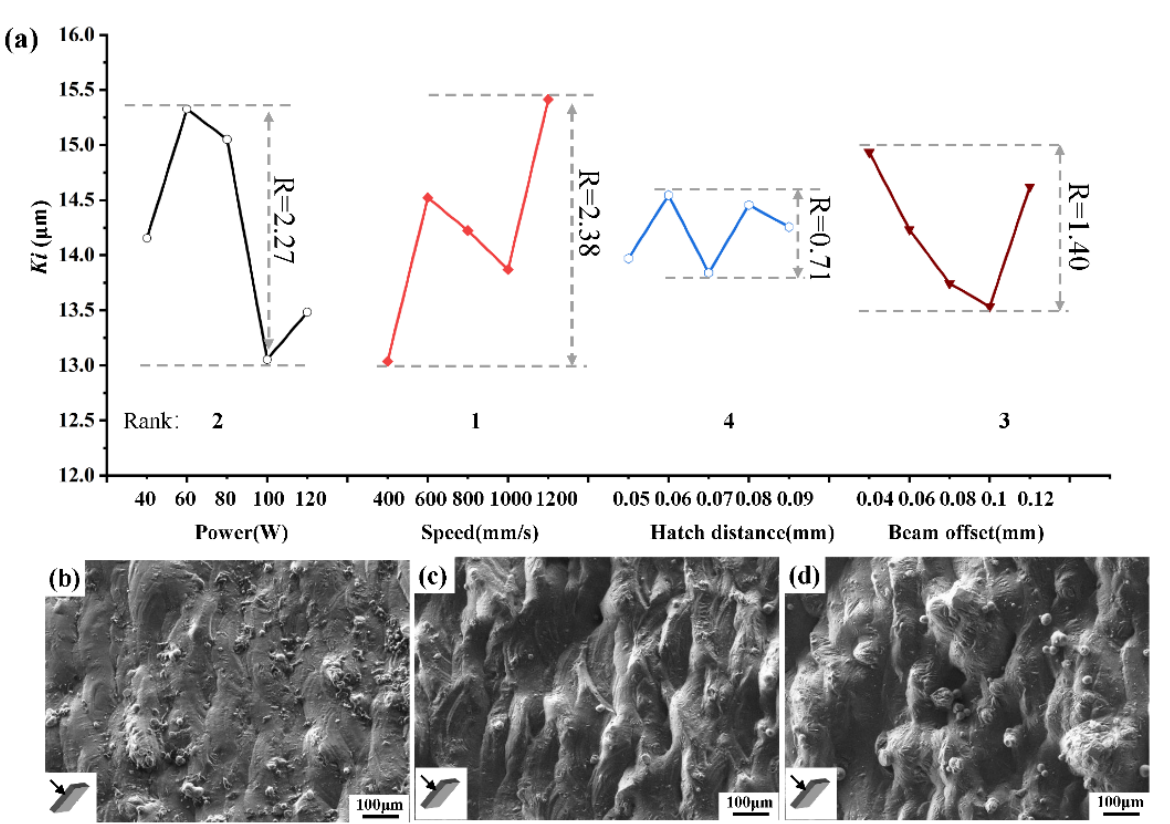
Figure 4. ( a )The factor-level trend curve of the up-facing surface roughness by range analysis. SEM images of inclined up-facing surface of LPBF parts using Doehlert design (Table 6): ( b ) No.3 (Ra = 6.92 µ m), ( c ) No.14 (Ra = 9.15 µ m), ( d ) No.20 (Ra = 12.78 µ m).